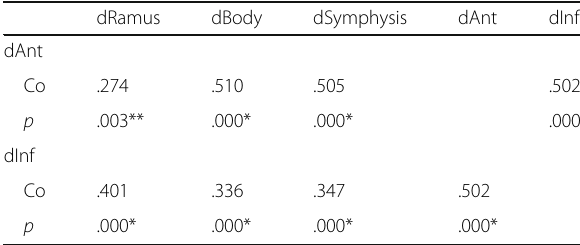
Table 4 Pearson ’ s correlation coefficiency in all patients dRamus